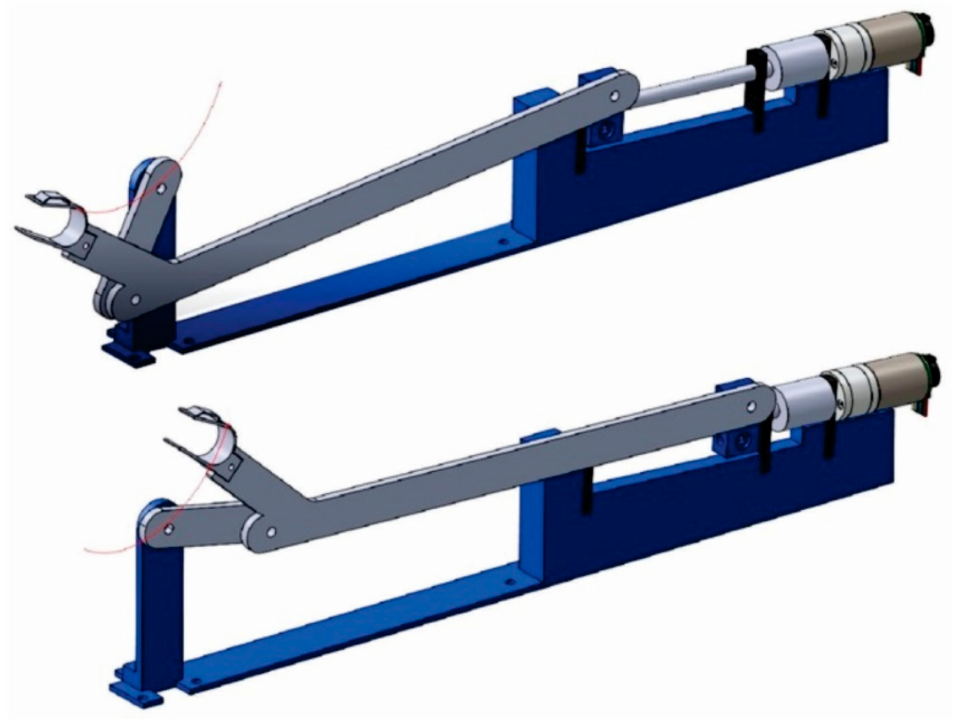
Figure 24. The new mechanism and the trajectory of the